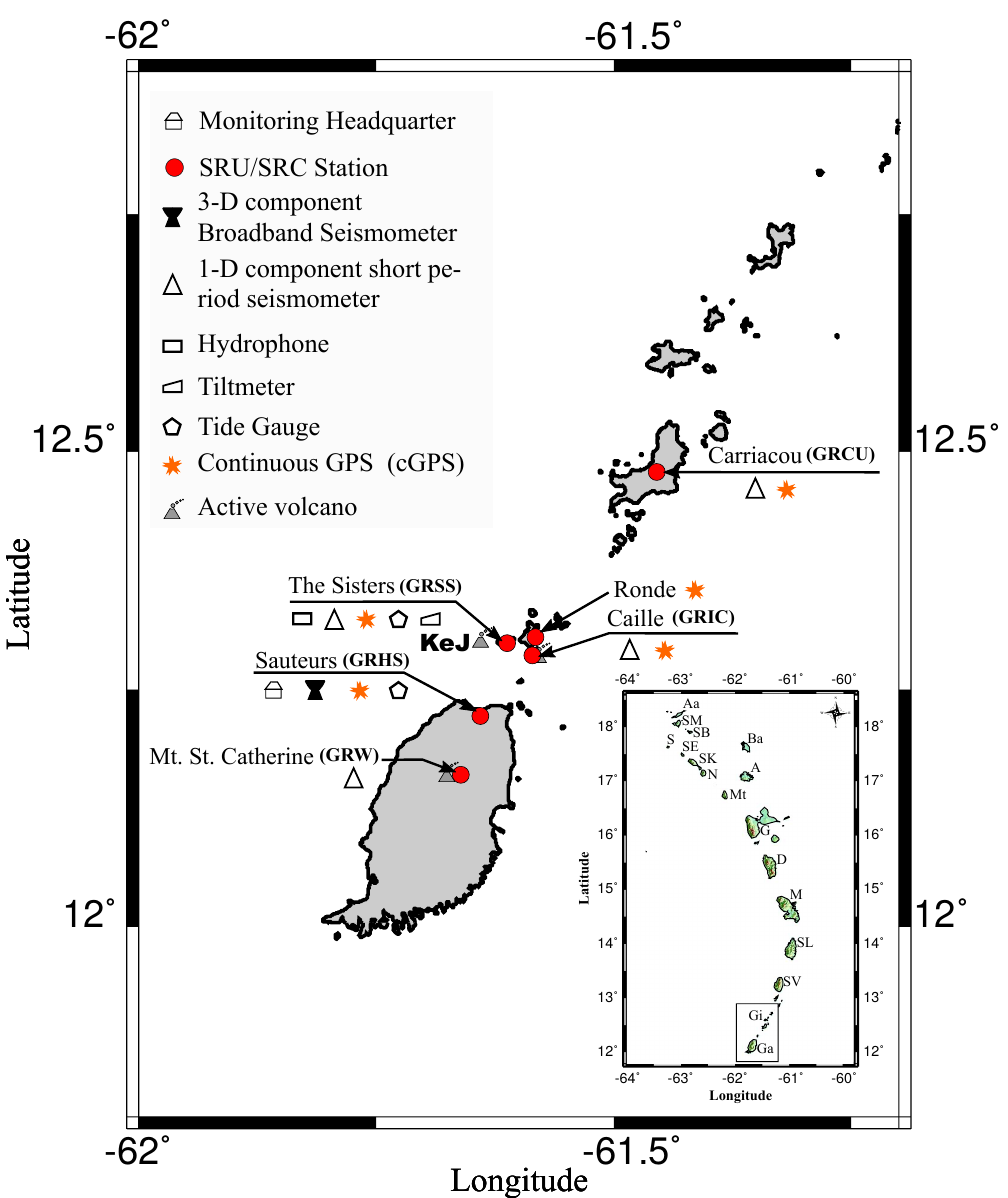
Figure 6. Map of the Grenada monitoring network as it was in early 2004 displaying the location of the stations GRW at Mt St. Catherine, GRHS at Sauteurs, GRIC at Isle de Caille, GRSS at the Sisters Islands, and GRCU at Carriacou. Inset: Antigua (A); Anguilla (Aa); Barbuda (Ba); Carriacou (Ca); Dominica (D); Guadeloupe archipelago (G); Grenada (Ga); Martinique (M); Montserrat (Mt); Nevis (N); Saba (S); St Bart (SB); St Eustatius (SE); St Kitts (SK); Saint Lucia (SL); St Marteen (SM); St Vincent (SV). Map is adapted from Figure 1 in [6]. KeJ: Kick-’em-Jenny submarine